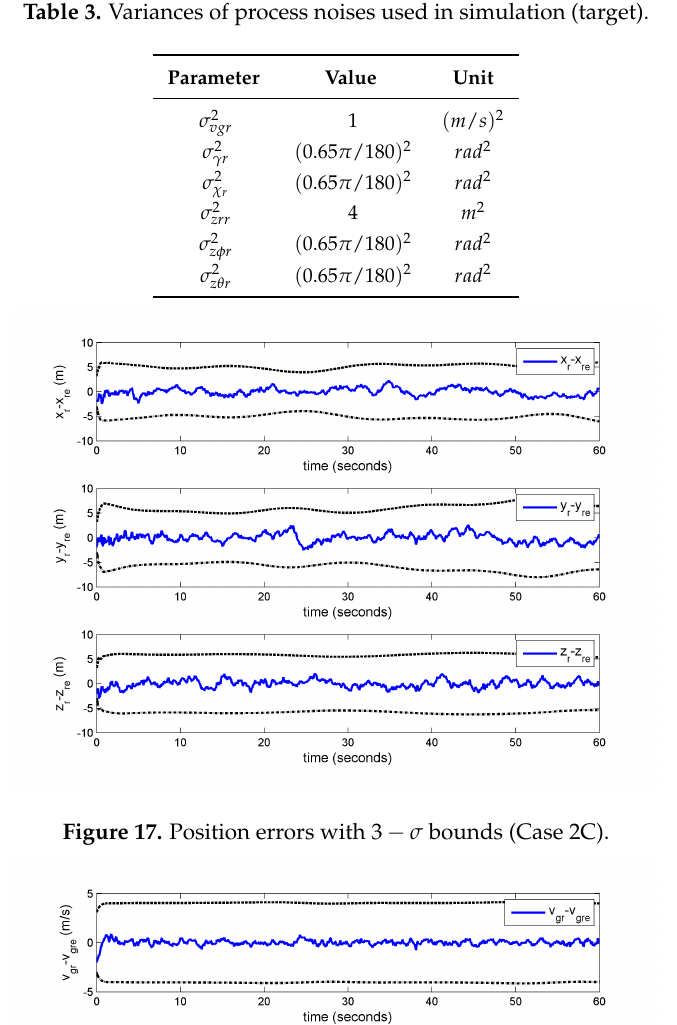
Figure 17. Position errors with 3 − σ bounds (Case 2C).